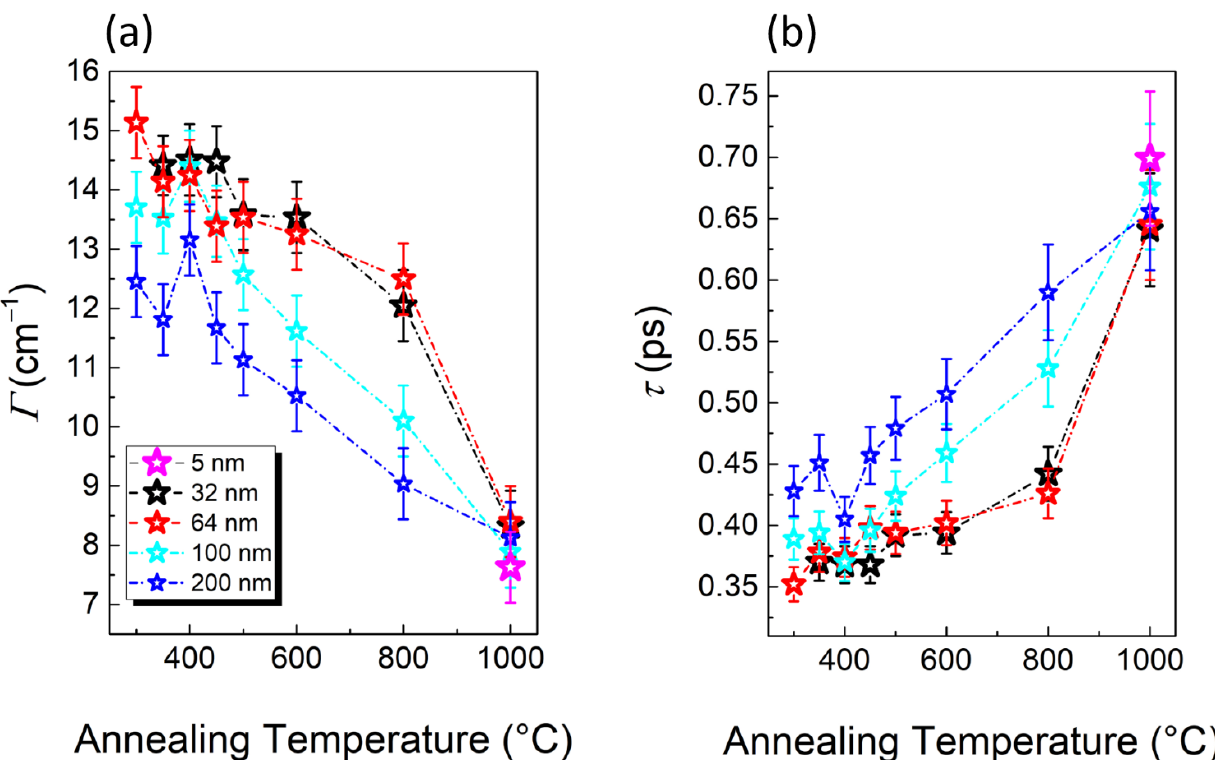
Figure 9. ( a ) Linewidth Γ values and ( b ) phonon lifetime τ as a function of the annealing temperature. The blue, cyan, red, and black stars indicate the 200, 100, 64, and 32 nm samples, respectively.